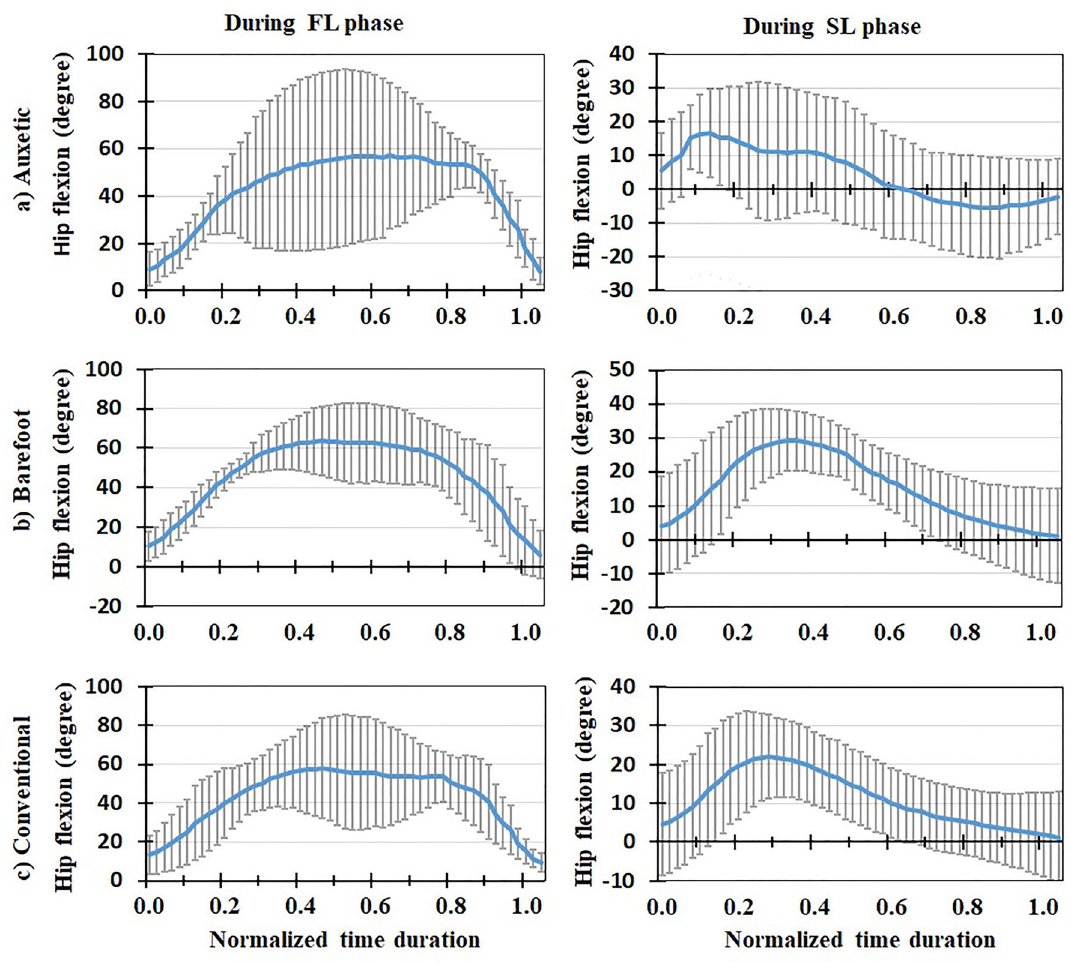
Figure 8. Mean hip flexion (degree) for all the participants (+ / − one standard deviation) in three footwear conditions: ( a ) auxetic shoe, ( b ) barefoot, and ( c ) conventional shoe. Left and right plots indicate variations during FL and SL phases of DVJ,